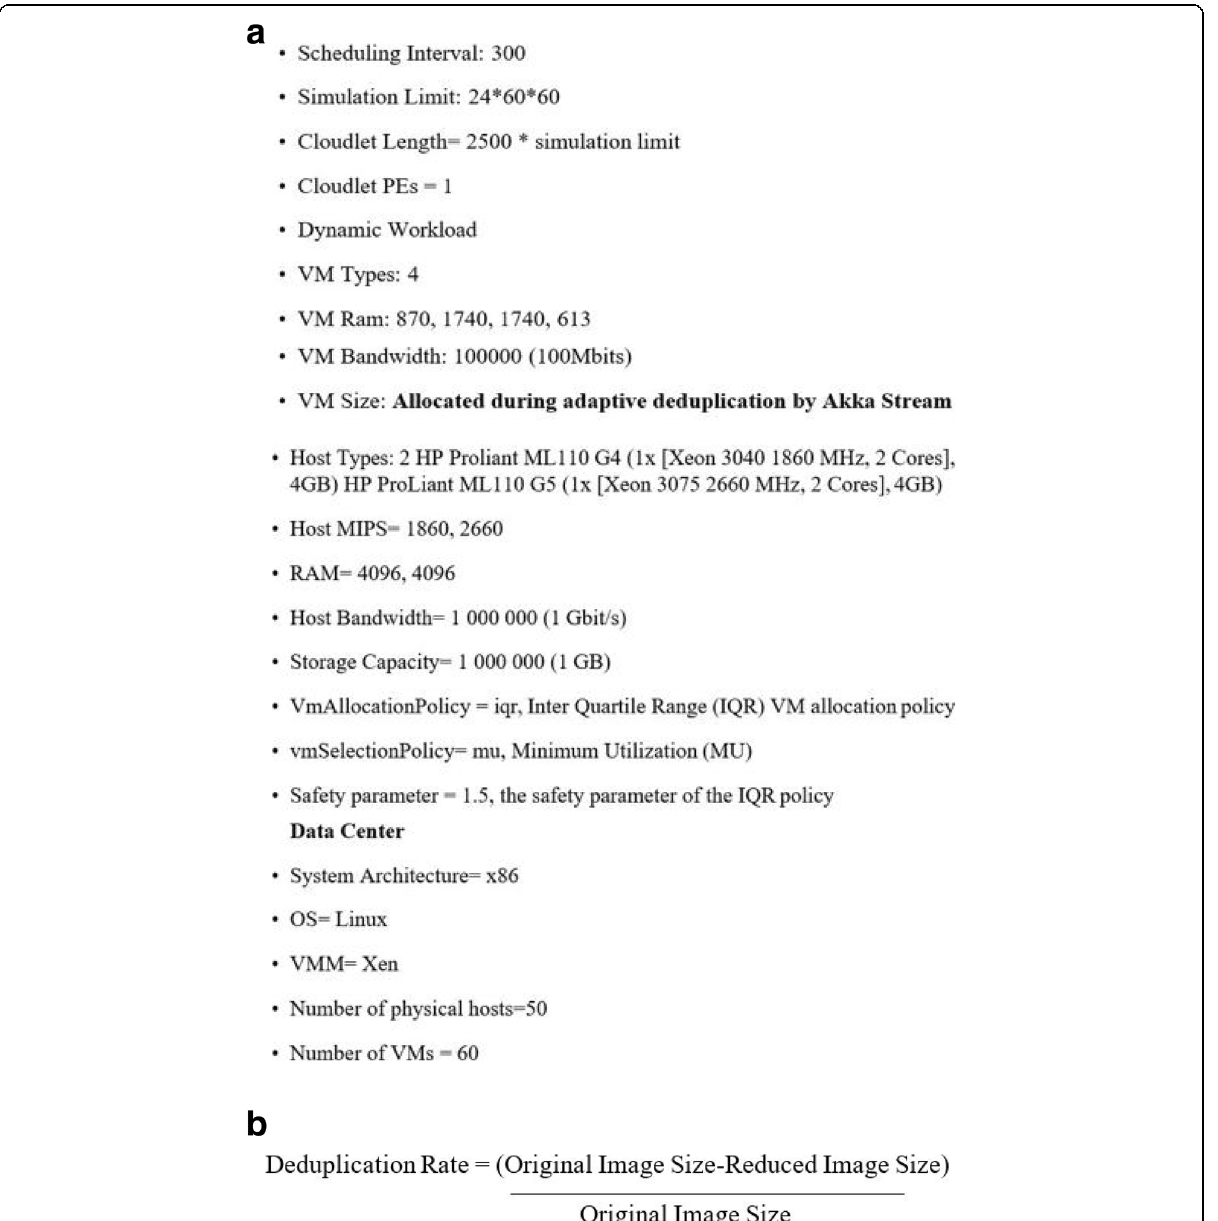
Fig. 4 a Testbed configuration of CloudSim. b Deduplication